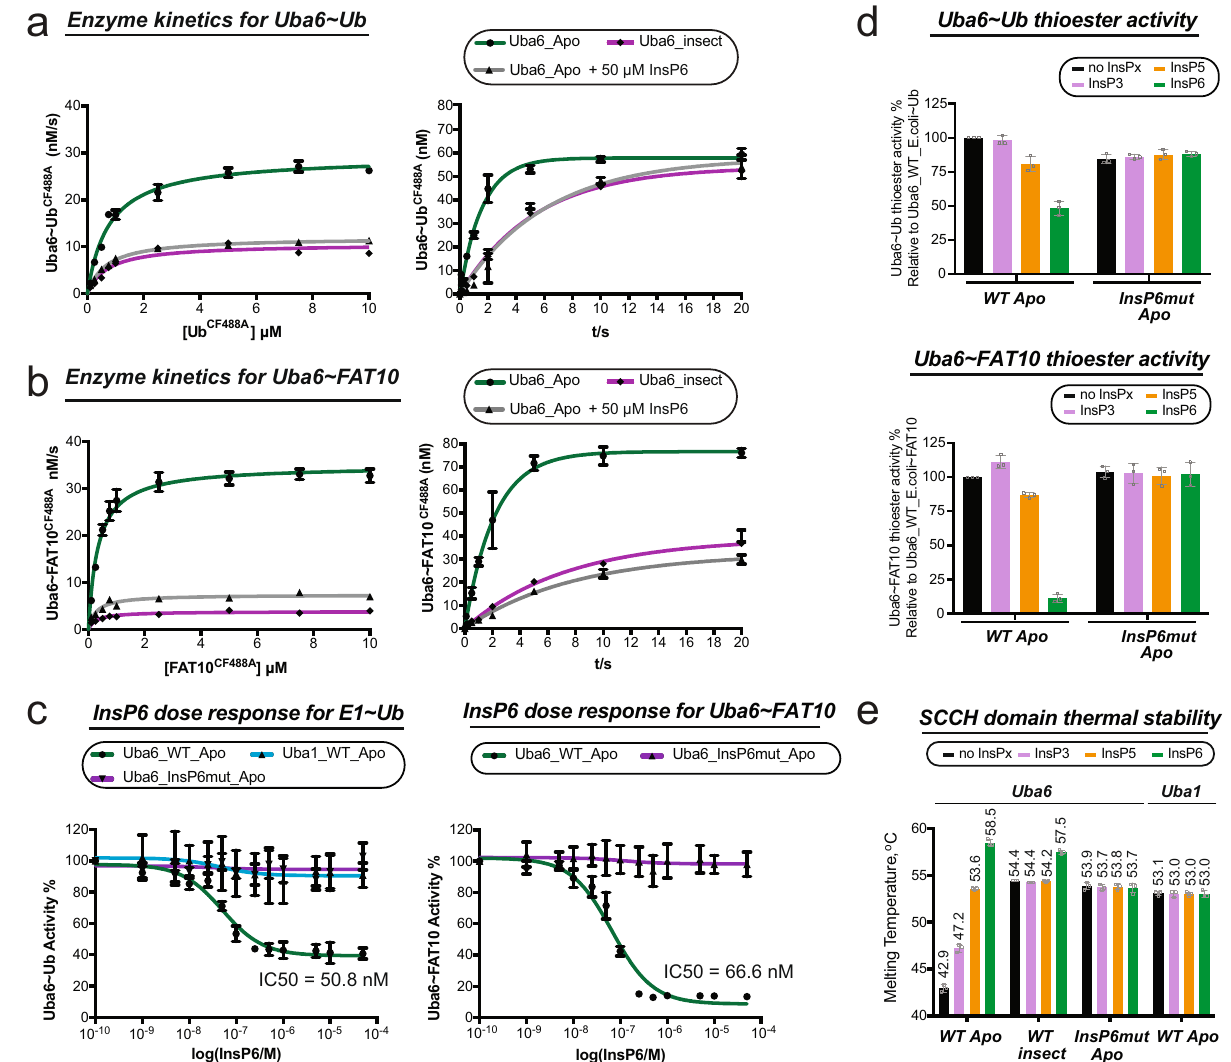
Fig. 4| InsP6inhibitsUba6E1~Ublthioesterformationactivityanditenhances itsstability.a , b Kineticcurvesof E.coli- derivedUba6inthepresenceandabsence of InsP6, and insect cell-derived Uba6, in Uba6~Ubl thioester activity assays. Throughout the fi gure, “ Apo ” labels refer to E. coli- derived material. Data are pre- sented as mean values+/ − SEM ( n =3 technical replicates). c IC50 curves for InsP6 inhibition of the Ub (Left) and FAT10 ( Right ) thioester formation activities of the indicatedUba6andUba1variants.Dataarepresentedasmeanvalues+/ − SEM( n =3 technical replicates). d Effects of InsP6 and other inositol polyphosphates on the Uba6~Ub (Top) and Uba6~FAT10 (Bottom) thioester formation activities of the